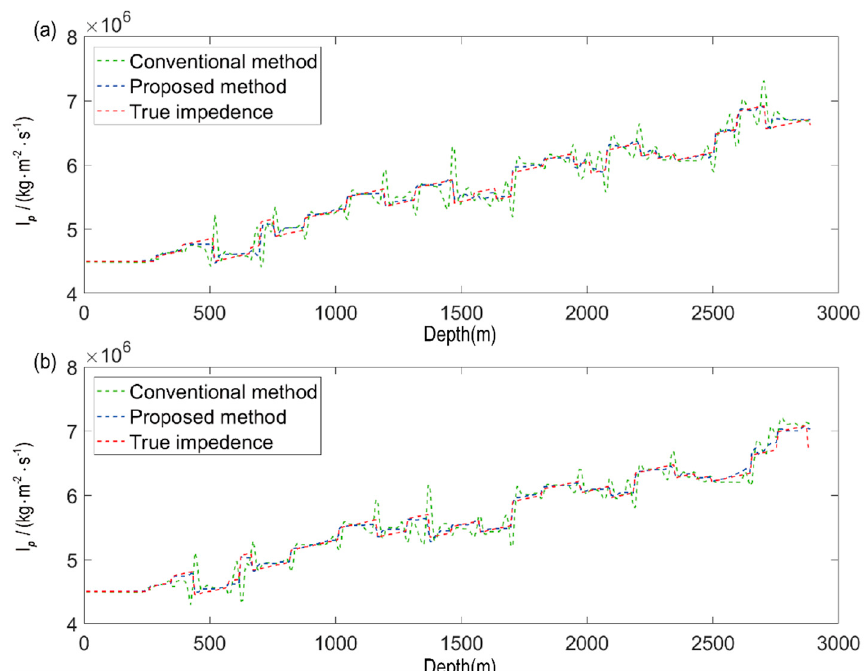
Figure 7. The extracted two traces at the horizontal position at 1840 m ( a ) and 3280 m ( b ) from Figure 5a,b, where the green, blue and red dashed lines represent the inverted impedance results from the conventional GBM, the proposed method and true reflectivity, respectively. The detailed comparison in space domain also shows the much better results produced by merging broadband image than the conventional image at both positions of 1840 m ( a ) and 3280 m ( b ).